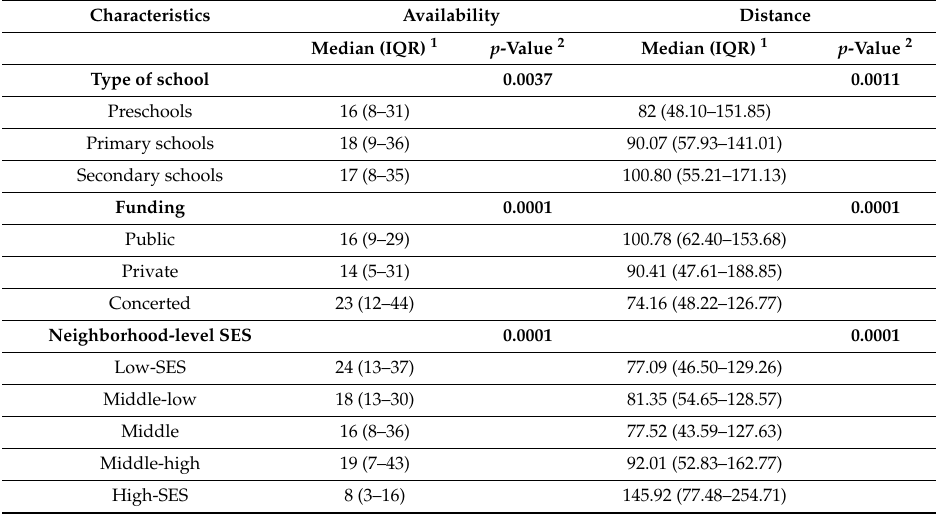
Table 1. Counts (within 400 m) of and distance (m) to unhealthy retailers across schools ( n = 1321) citywide (Madrid,